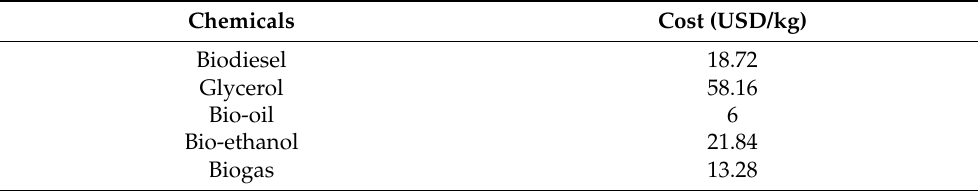
Table A3. Cost of